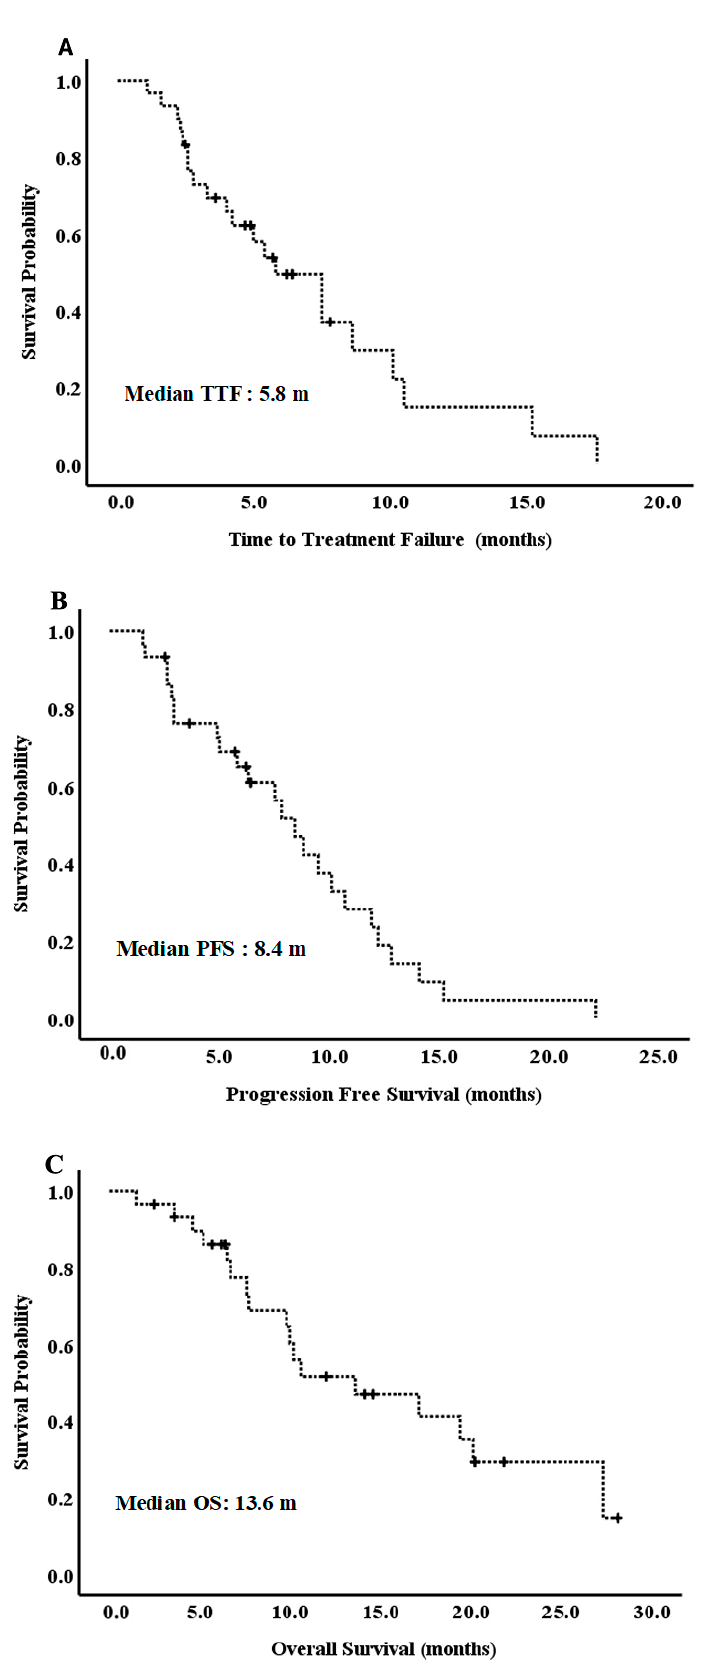
Figure 1. ( A ). Time-to-treatment failure (TTF); ( B ). progression free survival (PFS); and ( C ), overall survival (OS).